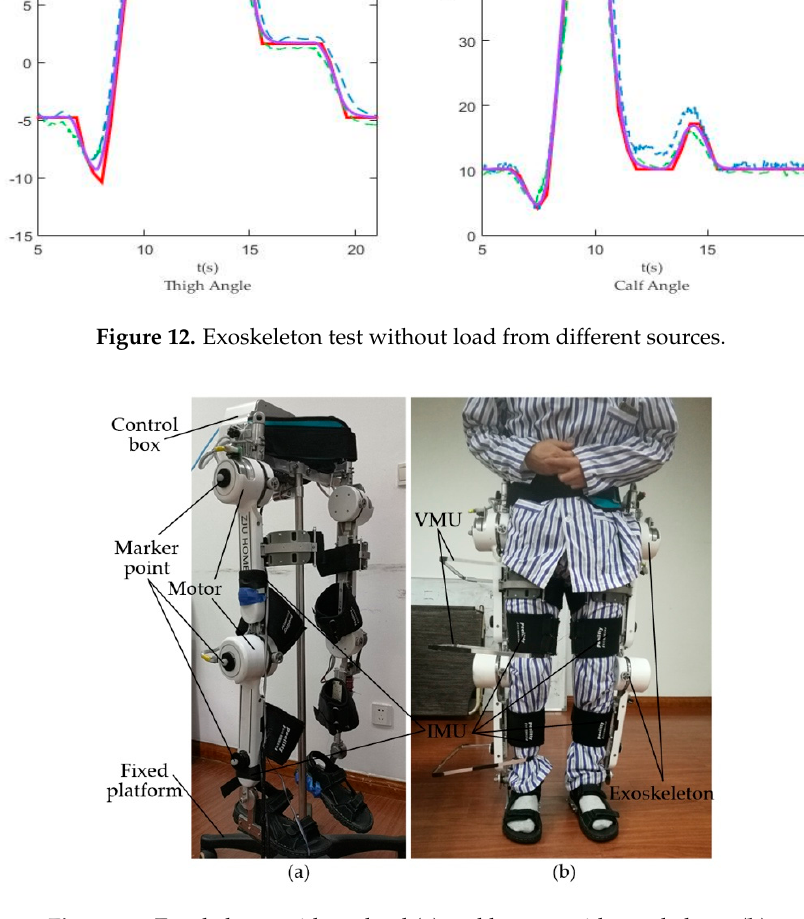
Figure 14. Actuate Curve Generation Process.